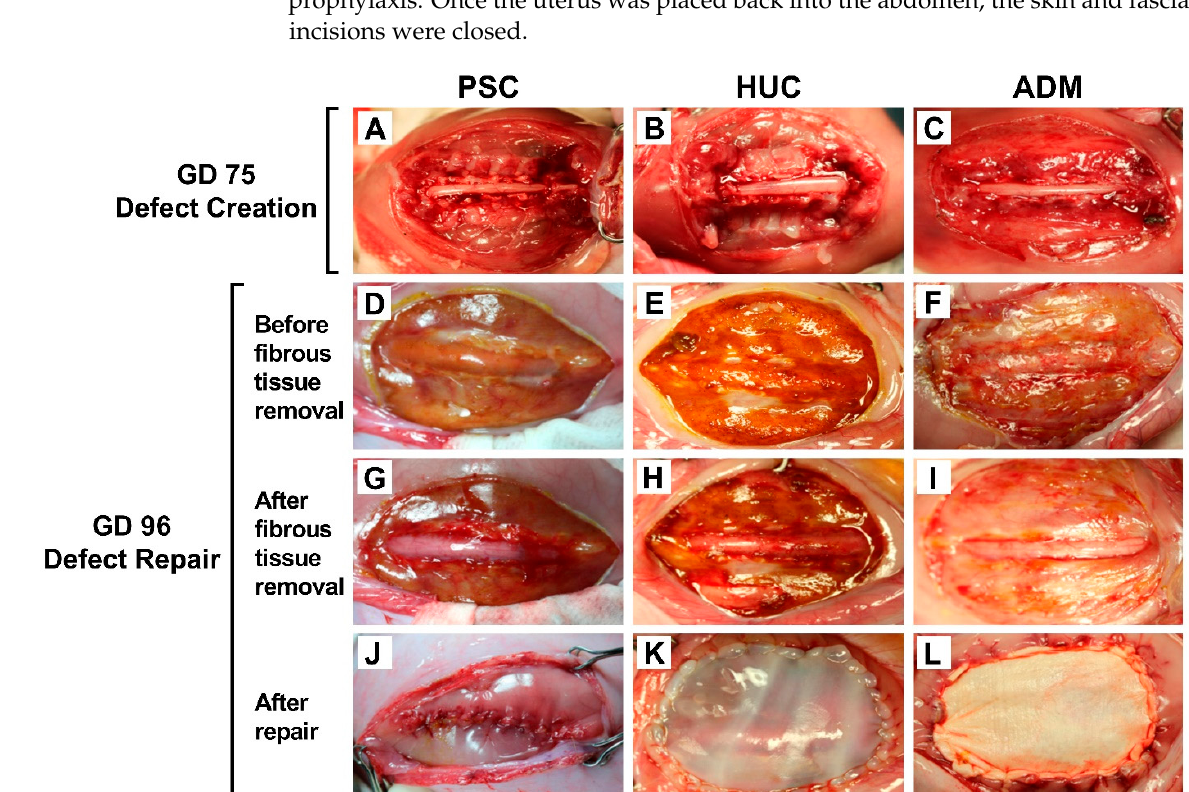
Figure 1. Creation and repair of spina bifida defects in sheep model fetuses. Representative images are depicted from the three SB surgical repair groups, with those being primary skin closure (PSC) and skin closure with either the cryopreserved human umbilical cord (HUC) or acellular matrix dermal (ADM) patches. ( A – C ) Creation of SB defects after skin, muscle, and posterior elements from the spinal canal and dura were removed, such that arachnoid layers were exposed. ( D – F ) Images of lesion sites immediately after lambs’ hysterotomies, showing fibrous tissue covering the lesions. ( G – I ) Images after fibrous tissue removal by microdissection to re-expose the meningeal layers and intact arachnoid layers. CSF can be appreciated beneath the meningeal and arachnoid layers. ( J – L ) Images showing repaired defects. ( J ) PSC was performed with full thickness mobilization of the skin, where subcutaneous tissue was sutured to the midline and then closed by primary closure. ( K ) The HUC patch was sutured circumferentially to the skin edges with its epithelial side facing the amniotic cavity and its mesenchymal surface facing the meningeal layer. ( L ) The ADM patch was sutured over the defect in a manner similar to that of the HUC patch.